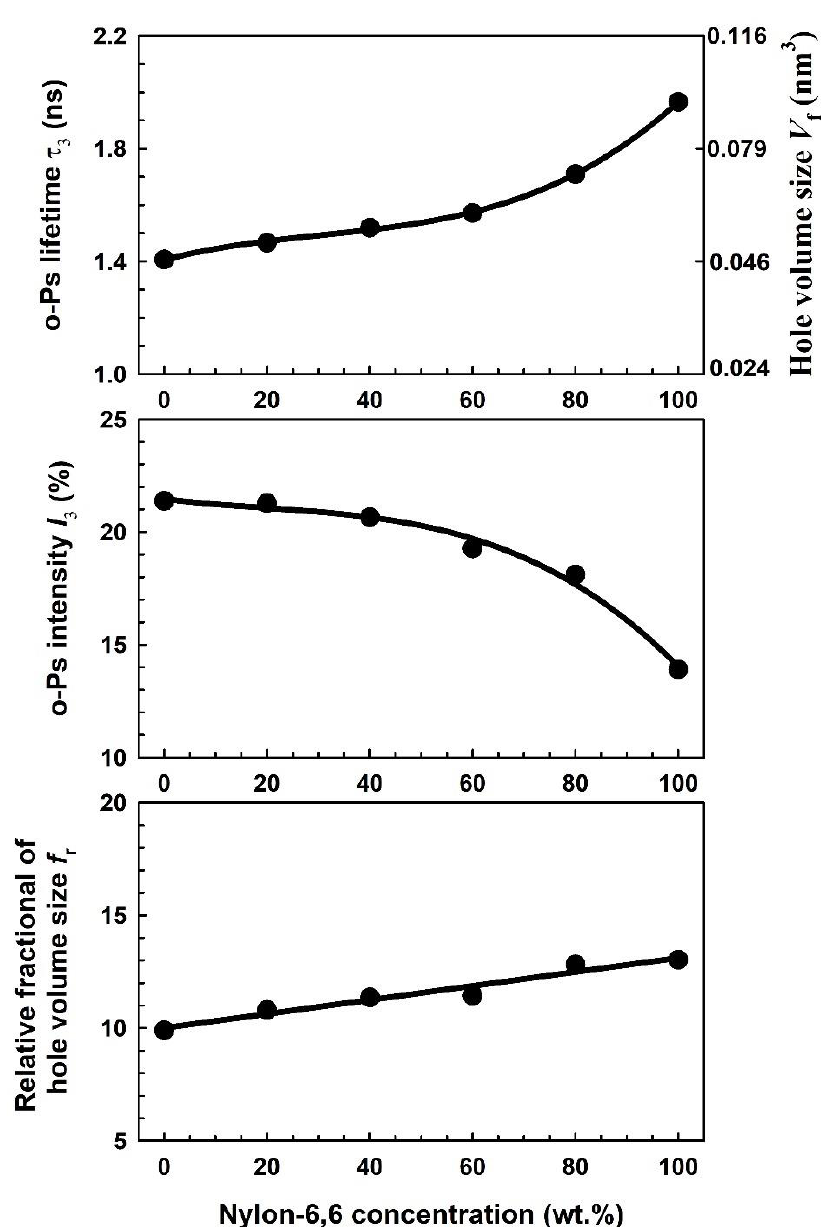
Figure 8. The o -Ps lifetime t 3 , its intensity I 3 , and relative fractional of hole volume f r as a function of Nylon-6,6 concentrations blended with PVA. Included in the right top figure is the hole volume size V f calculated using Equations (4) and (5).